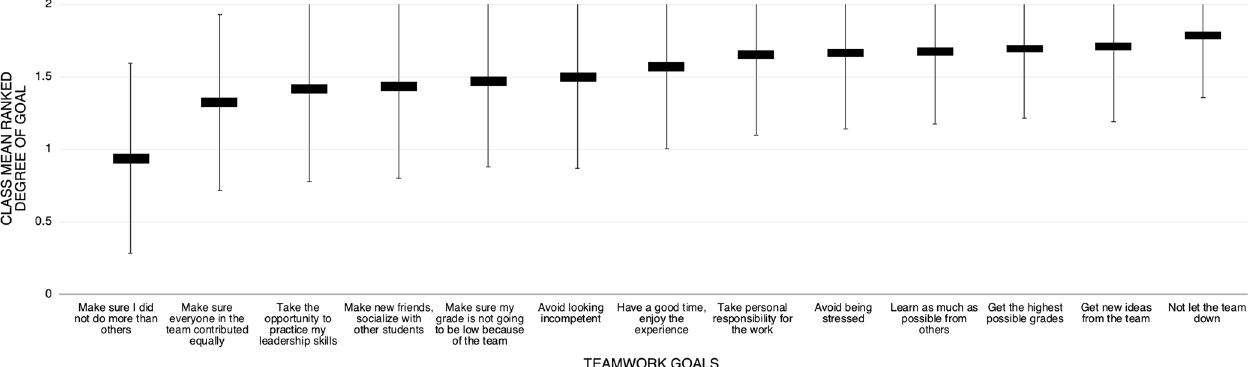
FIG. 1. Students were asked to rank the “ degree of importance ” of their teamwork goals on the AIRE survey. We plot the mean reported value of all the respondents where 2 is “ extremely ” or “ very ” important, 1 is “ moderately ” or “ slightly ” important, and 0 is “ not important at all. ” The whiskers represent plus and minus 1 standard deviation and the height of the bar is the standard error of the mean.